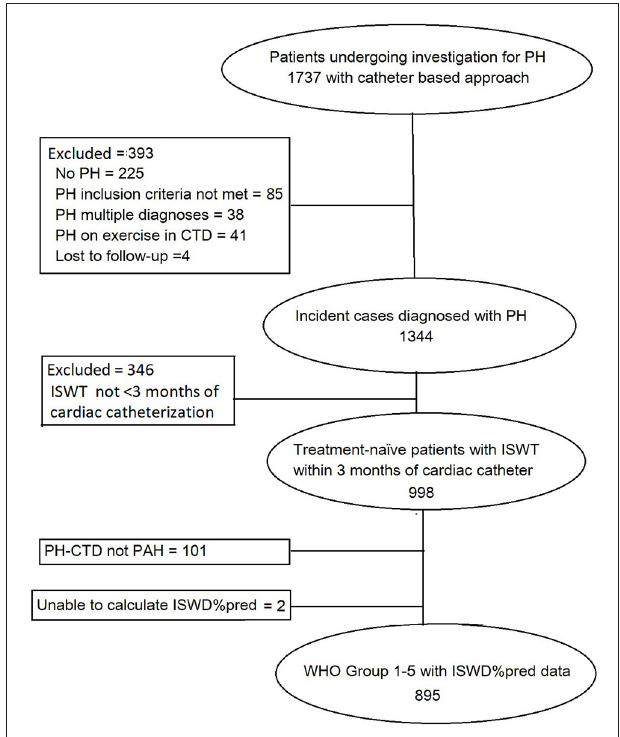
FIGURE 1 | Patient flow